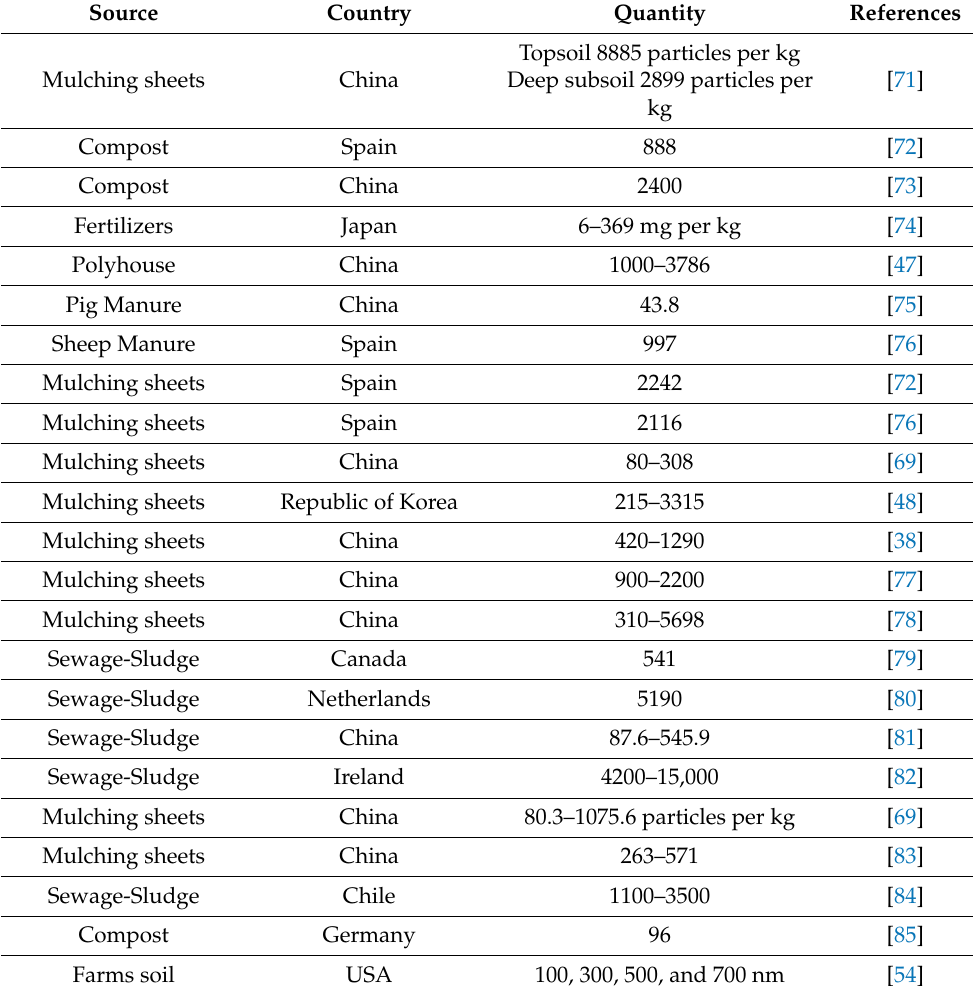
Table 3. Microplastic estimation from the different farms input to the